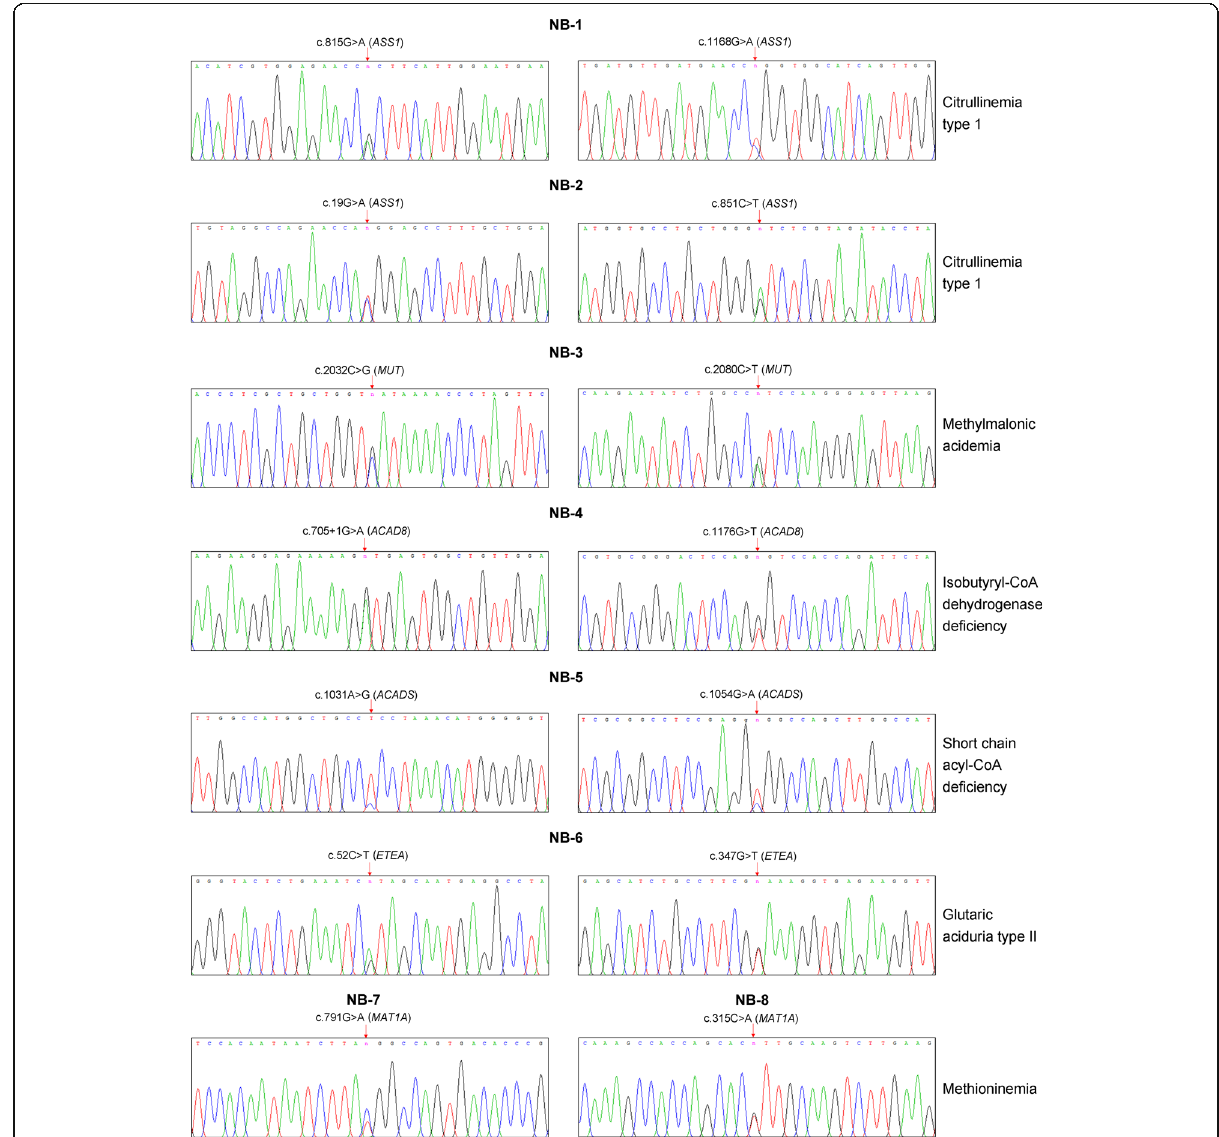
Fig. 2 Sanger sequencing confirmation of pathogenic IEM variants detected in 8 newborns diagnosed with an IEM (true